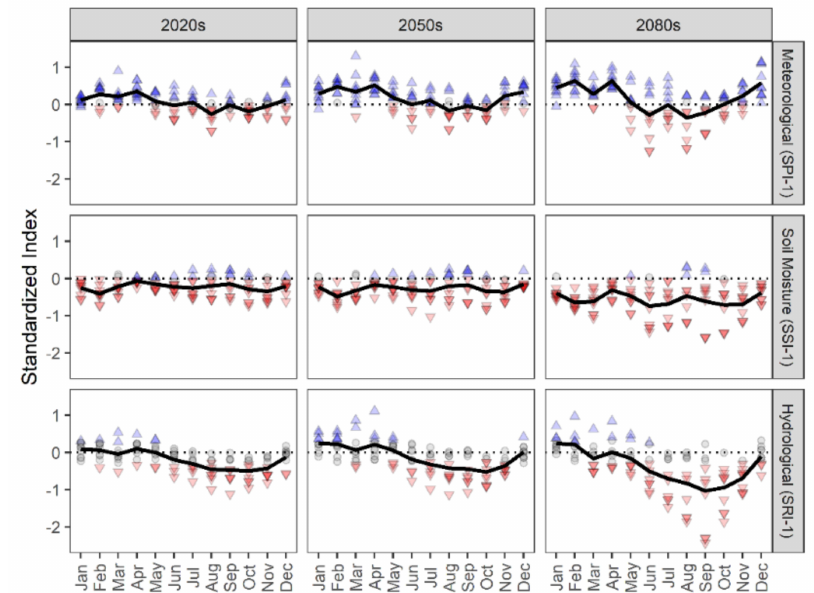
Figure 6. Monthly means of the standardized indices (SPI-1, SSI-1, and SRI-1) under representative concentration pathway (RCP) 8.5. Solid black lines show the GCM ensemble mean. Symbols represent individual GCMs from the 10-member ensemble, with blue up-pointing triangles indicating a significant ( p < 0.05) increase (wetter conditions) and red down-pointing triangles indicating a significant decrease